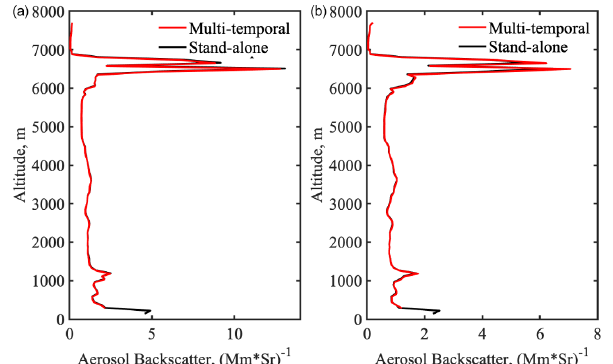
Figure 24. Aerosol backscatter profiles at 455nm (a) and 940nm (b) estimated from COBALD profiles acquired on 5 Au- gust 2015 using a stand-alone (black) and multi-temporal (red) re- trieval